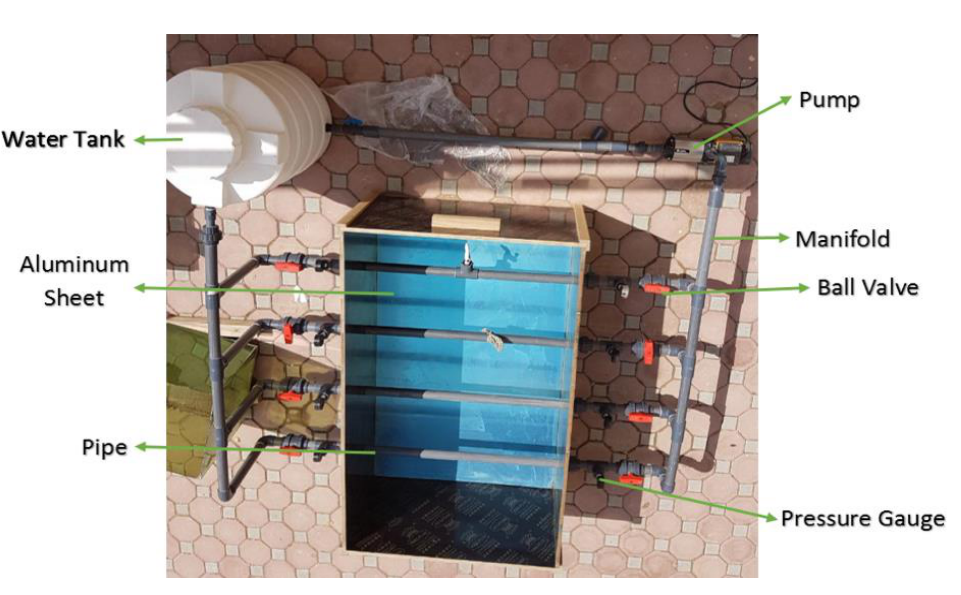
Figure 1. Experimental setup (top view).